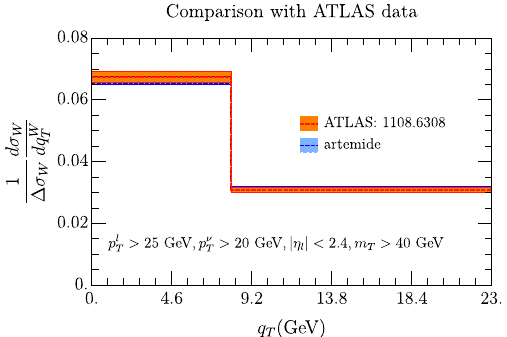
Fig. 12 Comparison of our prediction with data from ATLAS in [95, table II], including errors coming from scales variation